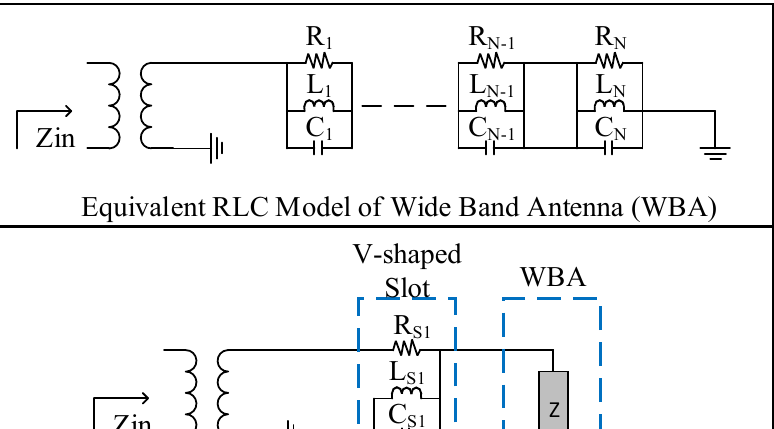
(WBA) [30,31]. Similarly, the notch bands occurred due to the presence of V-shaped slots were also model using an RLC group, where the LC equivalent notch frequency f no [32].